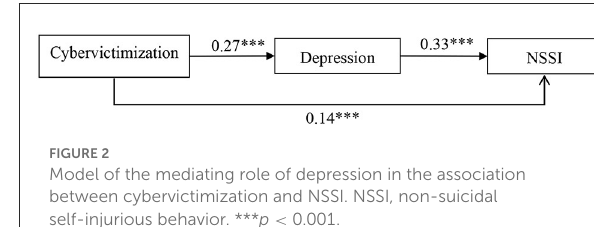
FIGURE2 Model of the mediating role of depression in the association between cybervictimization and NSSI. NSSI, non-suicidal self-injurious behavior. *** p <